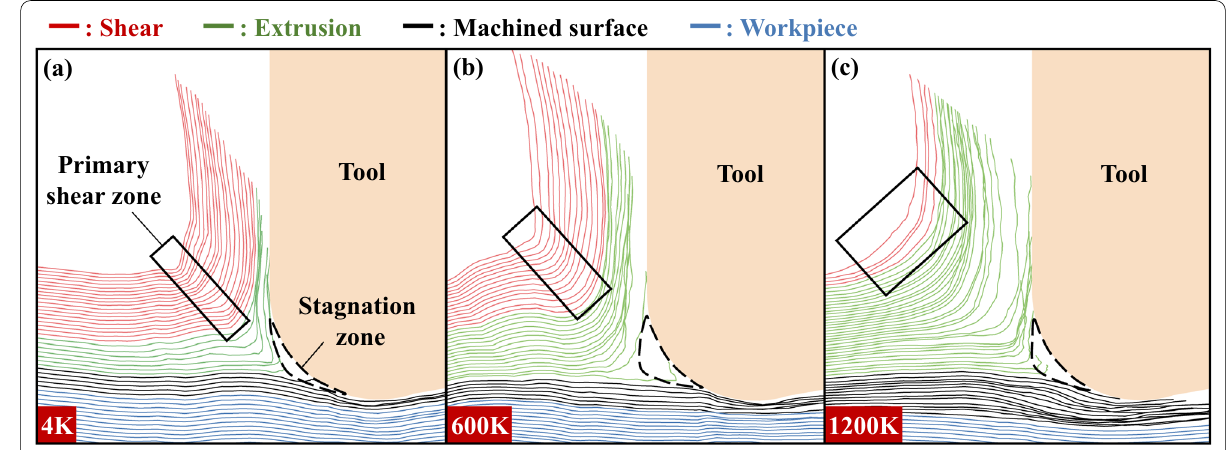
Fig. 12 Atomic motion trajectory a 4 K, b 600 K, c 1200